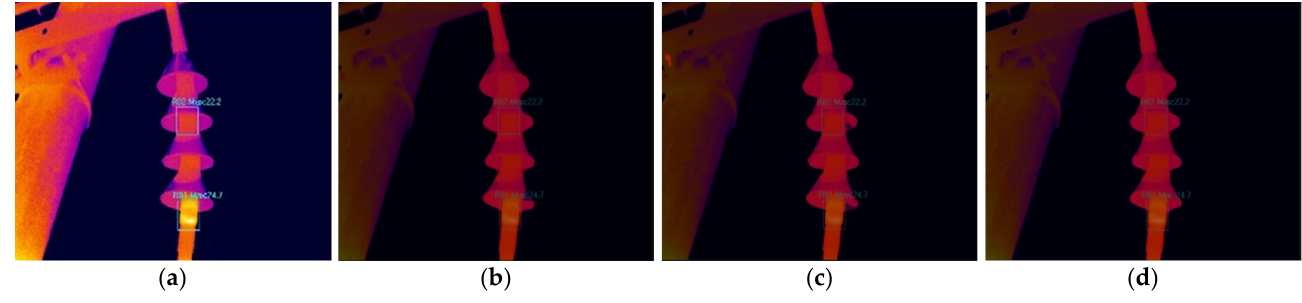
Figure 8. Original drawing and segmentation effects for 3 different models: ( a ) original drawing; ( b ) DeeplabV3+; ( c ) CBAM_DeeplabV3+; and ( d ) CS_DeeplabV3+.